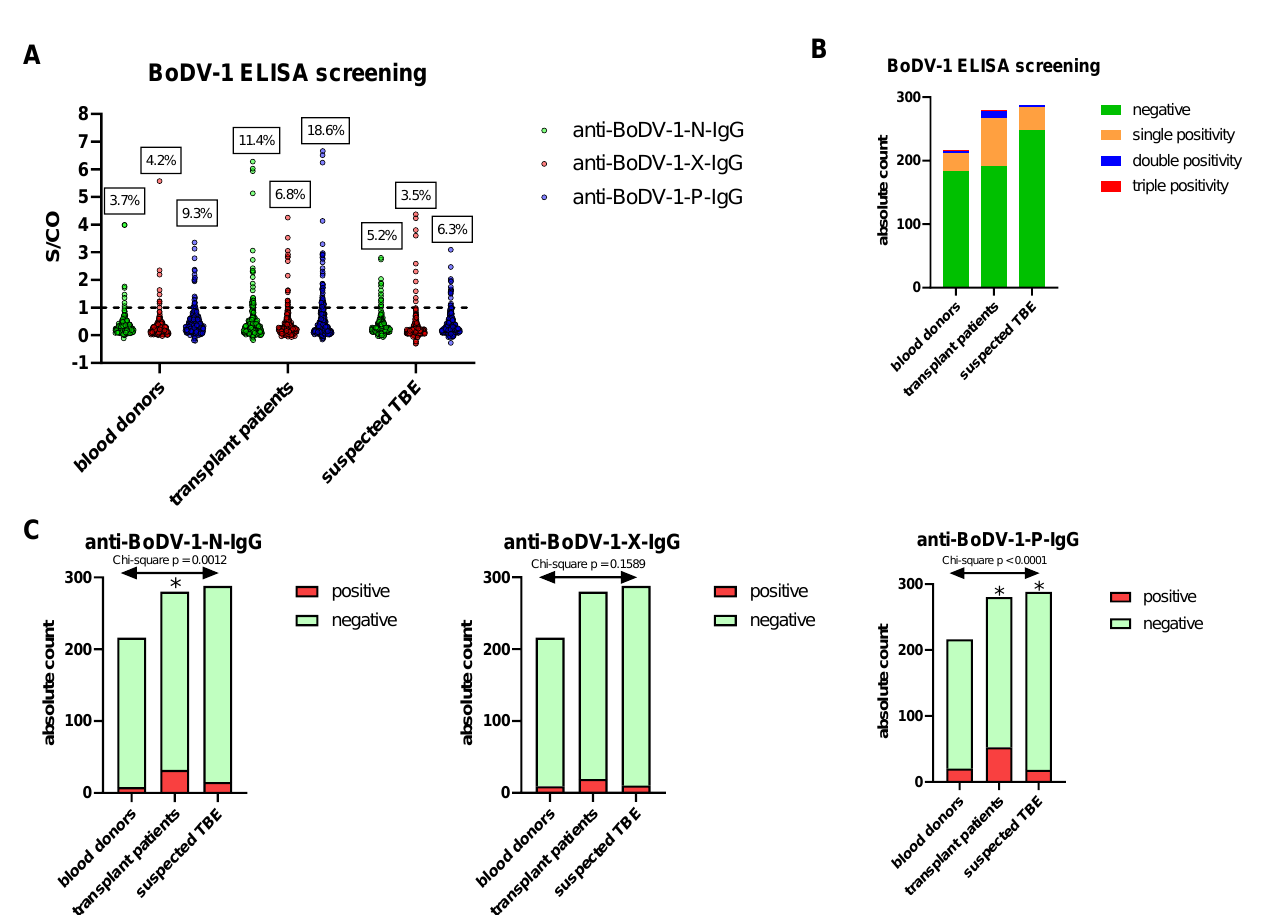
Figure 1. BoDV-1 screening ELISA. Three cohorts of healthy blood donors (n = 216), outpatients after solid organ transplantation (n = 280), and patients with requested TBE diagnostics (n = 288) were screened for anti-BoDV-1-IgG antibodies by an ELISA system using recombinant viral nucleocapsid (N), X, or phosphoprotein (P) as antigens. ( A ) shows the signal-to-cut-off ratios (S/CO) for individual samples and percentages of reactive samples for each cohort and antigen. Fractions of samples with IgG antibodies directed against none (negative), one (single positivity), two (double positivity), or three antigens (triple positivity) are depicted in ( B ). ( C ) shows the absolute counts of negative and reactive samples for each group and antigen. The variables “cohorts” and “test outcome” were statistically dependent for anti-BoDV-1-N-IgG ( p = 0.0012) and anti-BoDV-1-P-IgG ( p < 0.0001) based on chi-square tests. As post hoc test, the p -values of residuals were analyzed using Bonferroni correction. Residuals were significantly elevated for outpatients after solid organ transplantation (anti-BoDV-1-N-IgG, anti-BoDV-1-P-IgG) and significantly diminished for patients with the requested TBE diagnostics (anti-BoDV-1-P-IgG), as indicated by an asterisk.